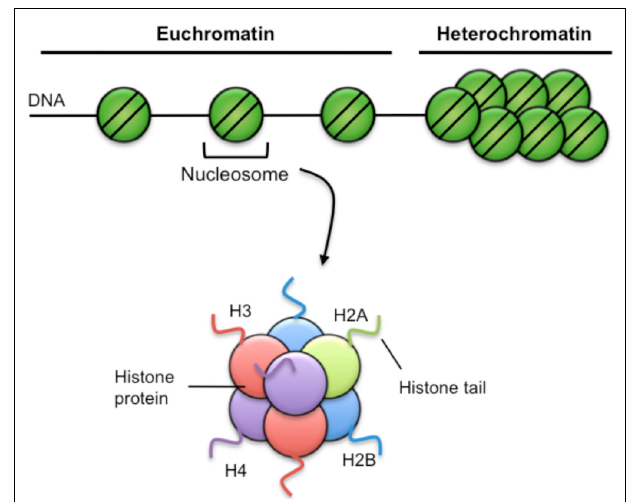
FIGURE 2 | Chromatin structure. Chromatin has two broad structures.The first is euchromatin, characterized by sparse nucleosome density and is generally associated with active gene transcriptional activity. Heterochromatin is characterized by high nucleosome density, is very compacted and is generally associated with repression of gene transcription. Nucleosomes consist of 147 bp of DNA wound 1.65 turns around a complex of histone proteins, comprising two each of the H2A, H2B, H3, and H4 histone variants. Each histone has a soluble amino terminal tail that can be covalently modified by specific epigenetic marks such as acetylation, methylation, and